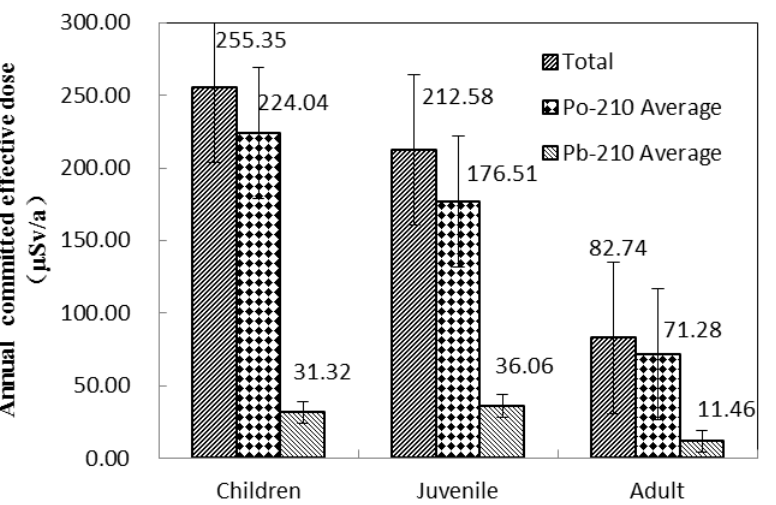
Figure 3. Effective ingestion doses due to the ingestion of 210 Pb and 210 Po through seafood consumption for different ages.